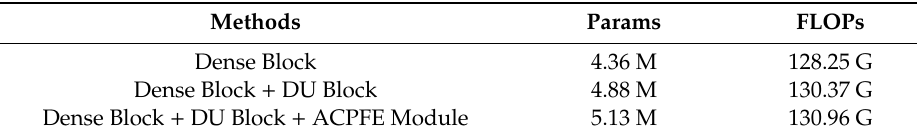
Table 2. Evaluation of MDA-Net with di ff erent settings.